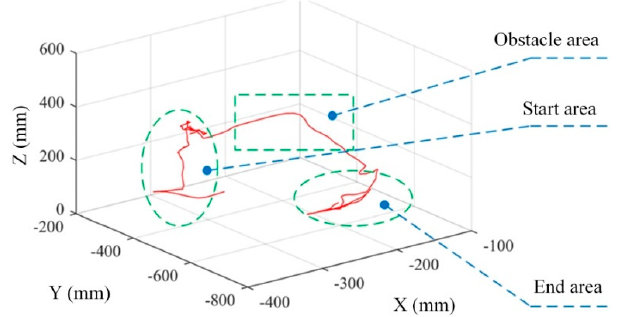
Figure 14. Cartesian trajectory of manipulator.